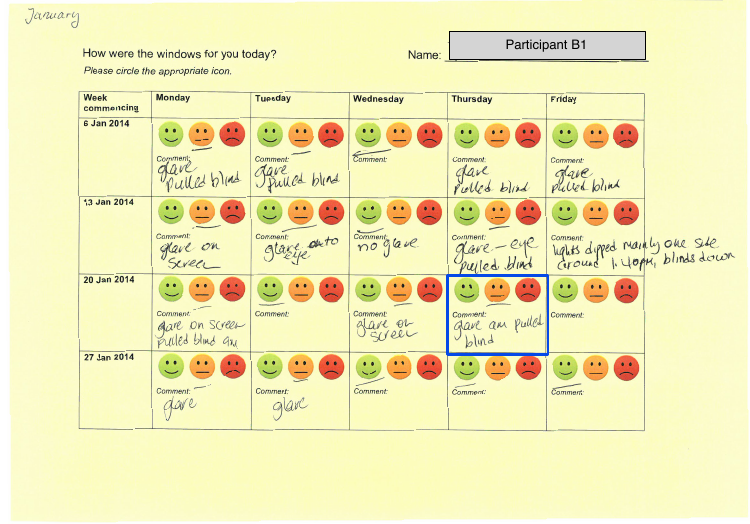
Figure 6. Example of a daily experience sheet, showing responses from Participant B1 in January 2014 (example day highlighted with a blue